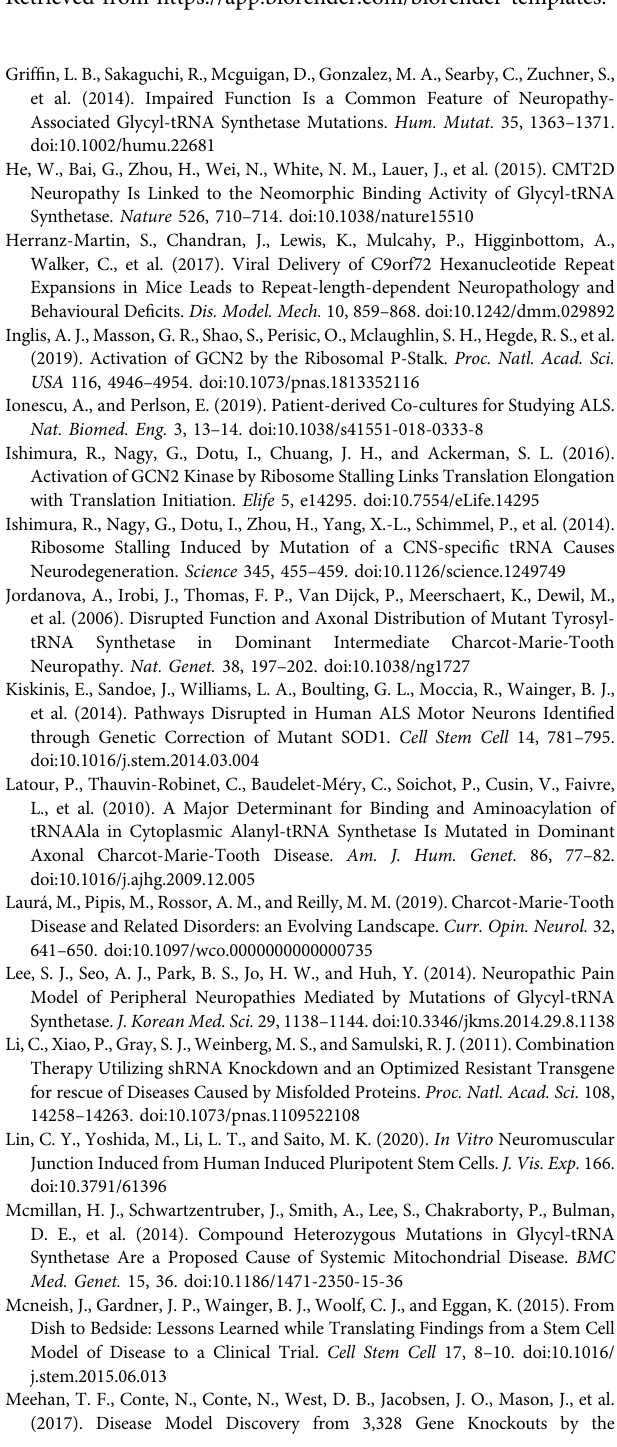
Figure 2 was adapted from “ iPSC-Based Disease Modeling of Childhood Neurogenetic Disorders ” , by BioRender.com (2021). Retrieved from